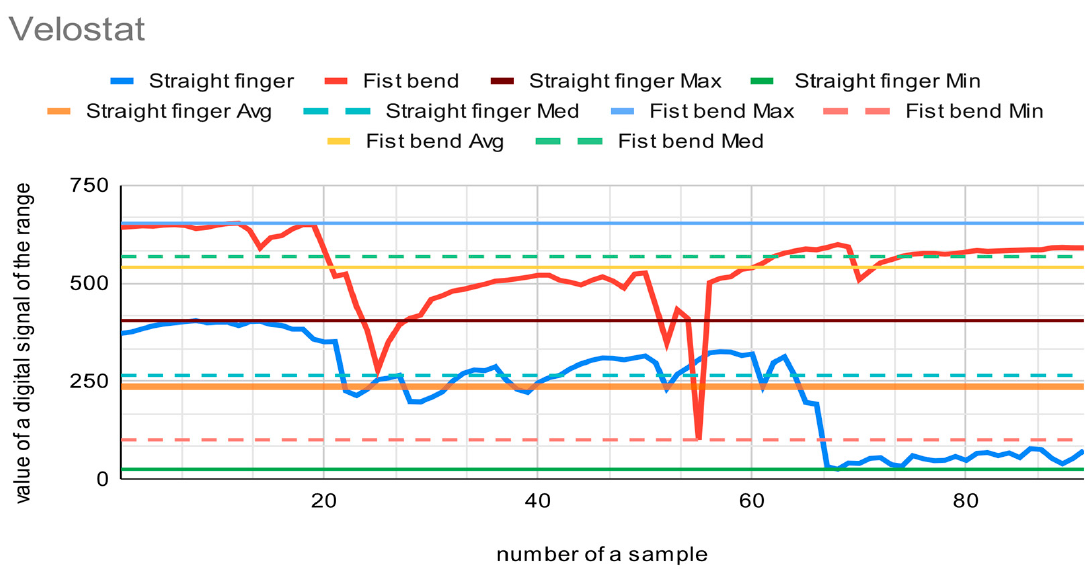
Figure 9. Chart showing samples collected with the Velostat material as a core for the bend sensor.